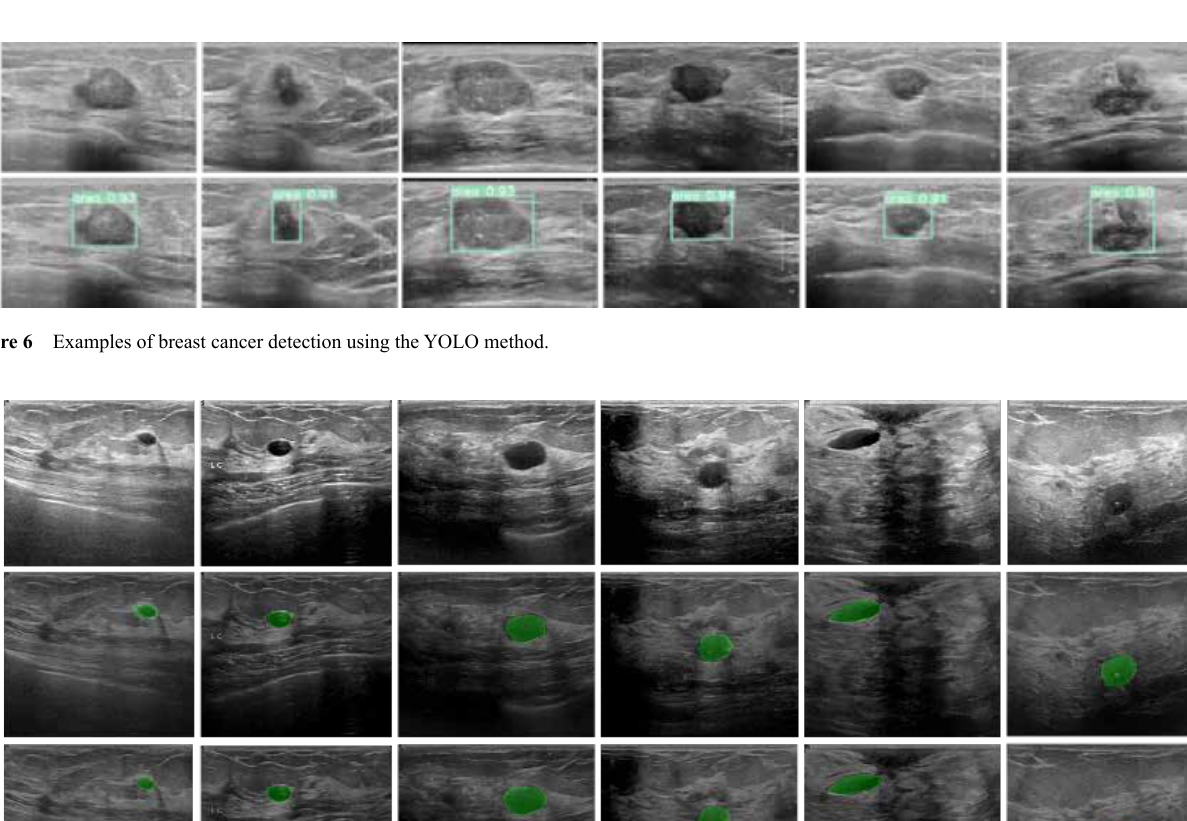
Figure 5 The noise reduction results of US images with the Gabor-based anisotropic diffusion (GAD), GAN and CycleGAN.